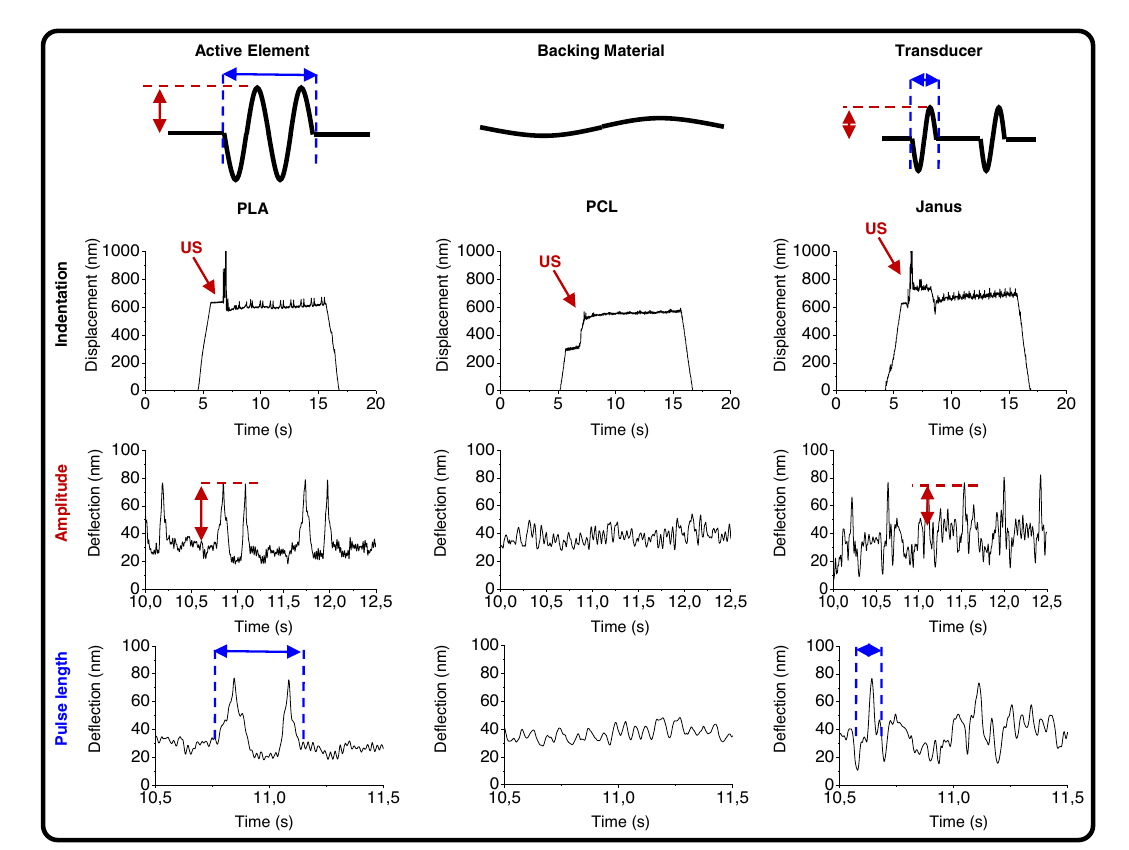
Fig. 3 Janus scaffolds respond to ultrasound stimulation as transducers composed of a reactive material (PLA) and a backing material (PCL), and affect matrix deposition by cells. Schematic representation of the response of the different components of a transducer element (top). Graphs of indentation experiments (bottom) on PLA, PCL and Janus scaffolds showing a decrease of the amplitude (red arrows) and pulse length (blue arrows) on Janus scaffolds as compared to PLA scaffolds upon ultrasound stimulation at 40 kHz (red arrows labeled